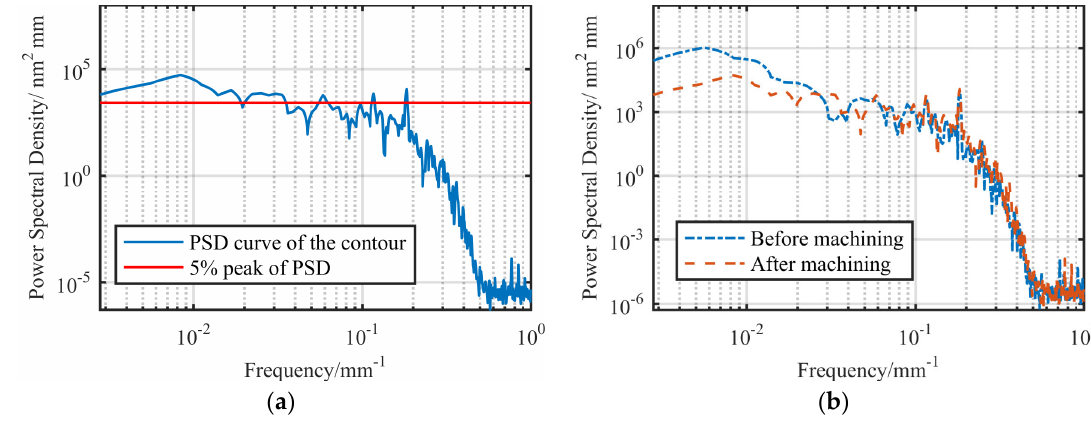
Figure 14. PSD analysis of peripheral contour after machining: ( a ) PSD characteristic curve after machining; ( b ) comparison of PSD characteristic curve before and after machining.